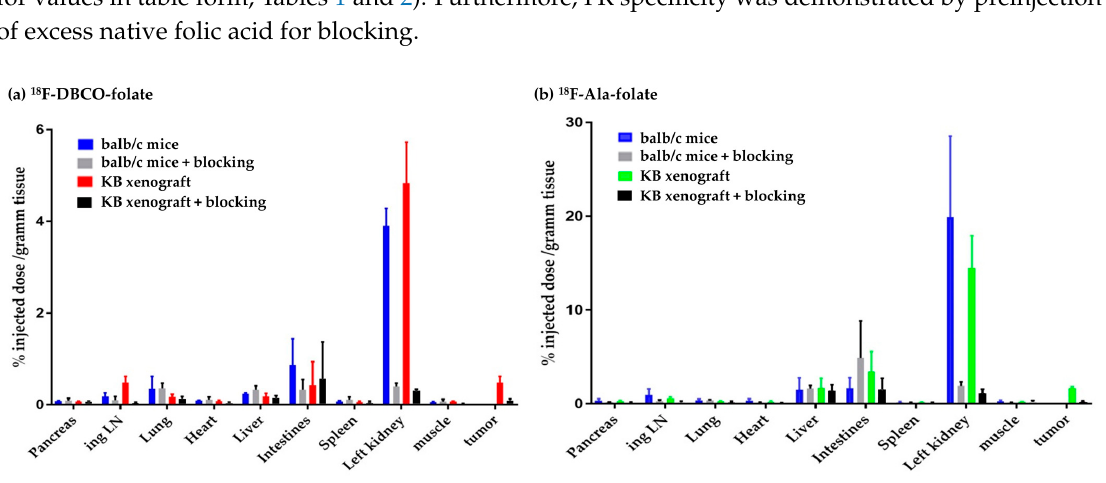
Figure 3. Results of biodistribution of 18 F-DBCO-folate ( a ) and 18 F-Ala-folate ( b ) at 60 min p.i.